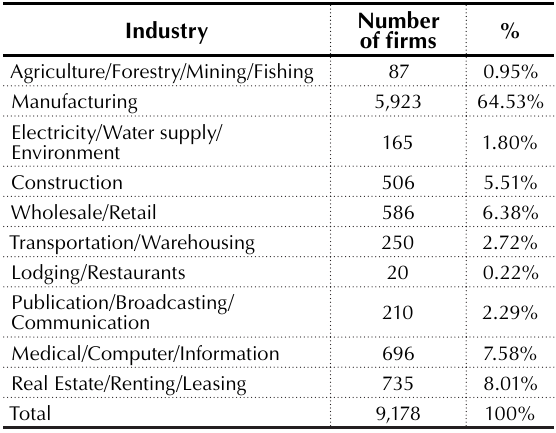
Table 1. Industry distribution of the